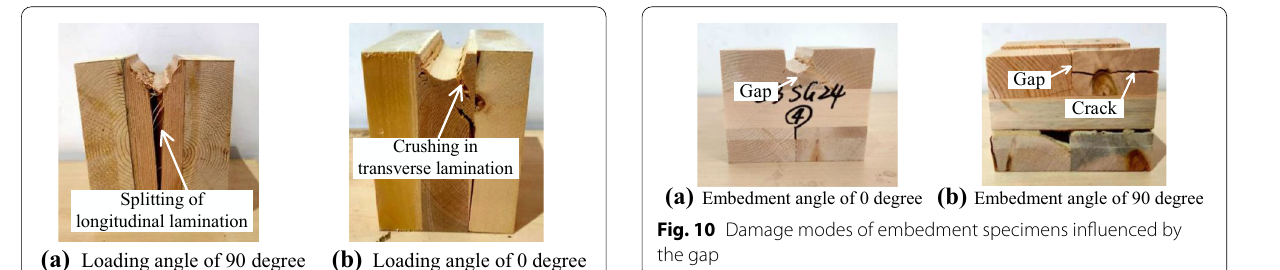
Fig. 7 Specimen with dowel positioned within a single layer